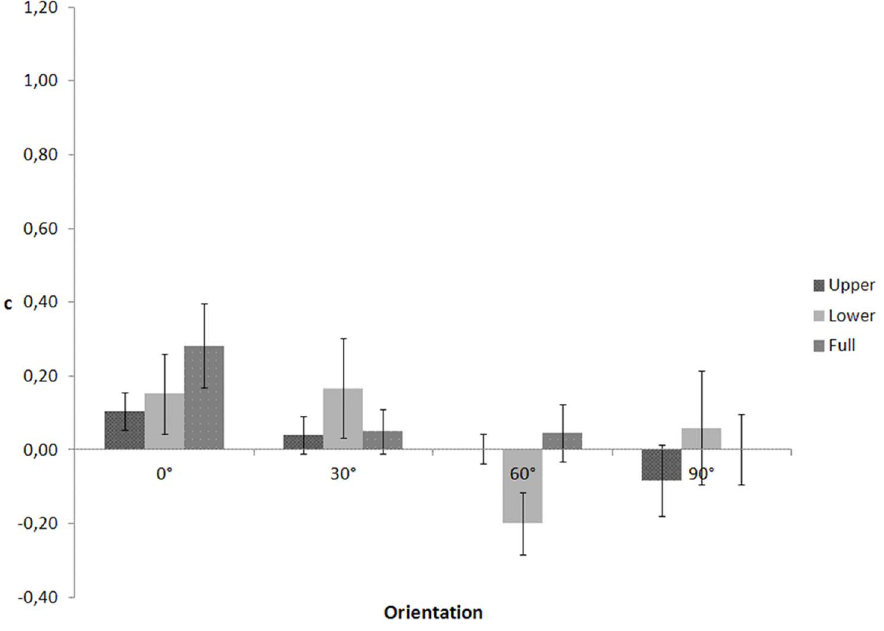
Fig. 10. c as a function of visible body part and figure orientation for the rowing action in Experiment